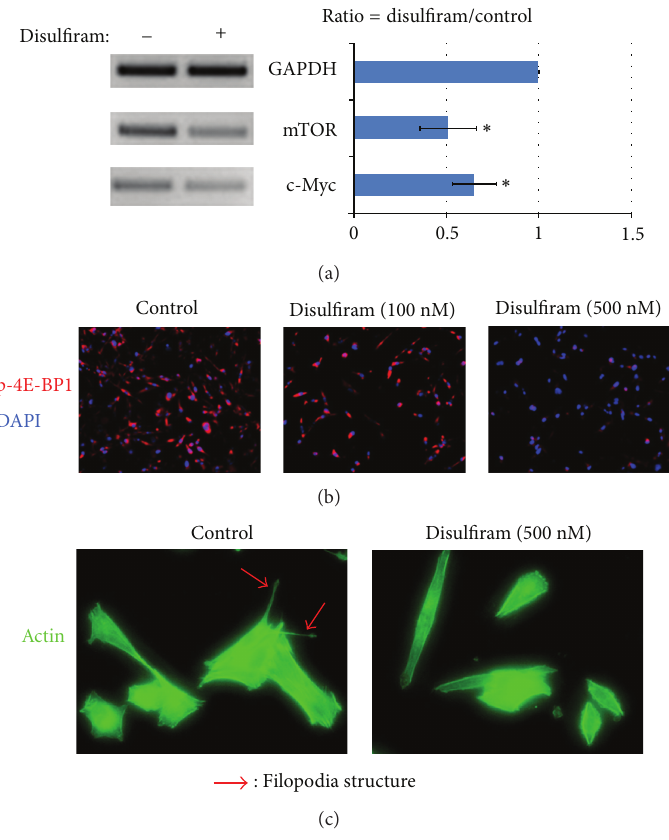
Figure 6: Inhibition of ALDH with disulfiram inhibits metastatic properties of ALDH-high K7M2 cells. (a) Disulfiram (250nM) was added to ALDH-high K7M2 cells and the cells were cultured for at least 24 hours in 10% FBS growth medium. RT-PCR was used to determine gene expression differences as a result of this treatment, with GADPH used as a control. Both mTOR and c-Myc expression were reduced as a result of the treatment with disulfiram. (b) Immunostaining with phospho-4E-BP1 (a mouse anti-mTOR antibody) was done to confirm that treatment with disulfiram reduced expression of mTOR As the concentration of disulfiram was increased (0nm, 100nm and 500nm) cells displayed progressively less mTOR expression. (c) Morphologic differences after treatment with disulfriam were also present, with disulfiram treated cells (stained for actin) appearing less pleomorphic and with fewer